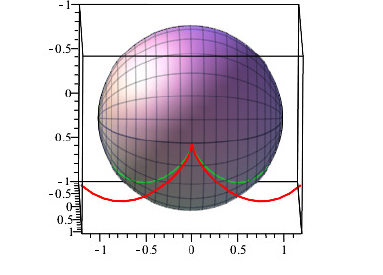
Figure 2. The red curve γ 2 ( s ) is the framed rectifying curve, and the green curve g 2 ( s ) is a curve on S 2